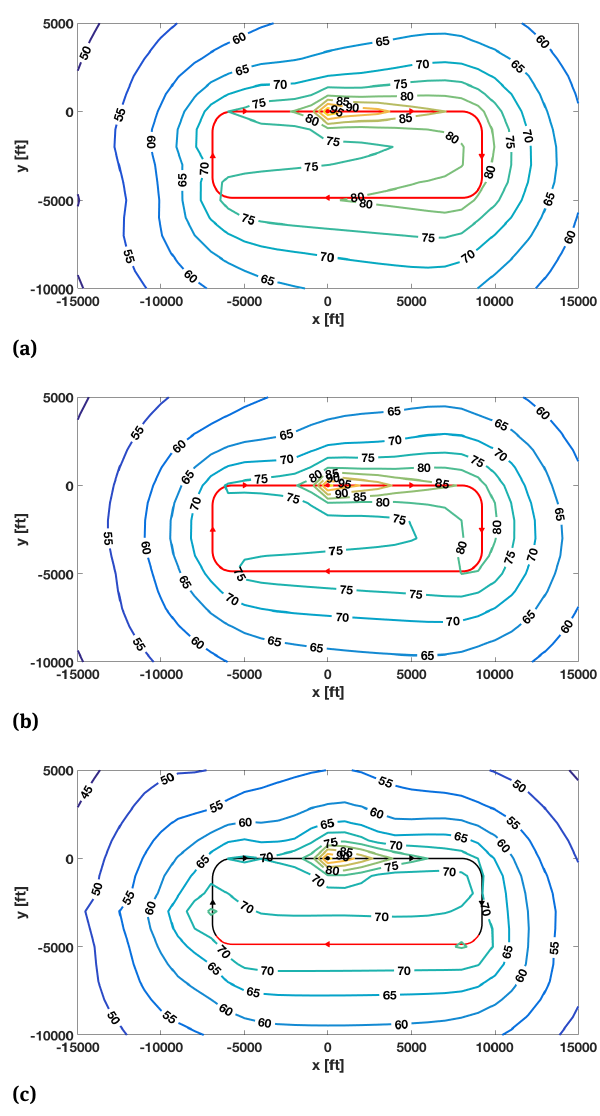
Figure 7: Contour plots of SEL, same grid as Figure 6. (a) Cessna C172R Skyhawk. (b) Pipistrel Panthera. (c) Pipistrel Panthera